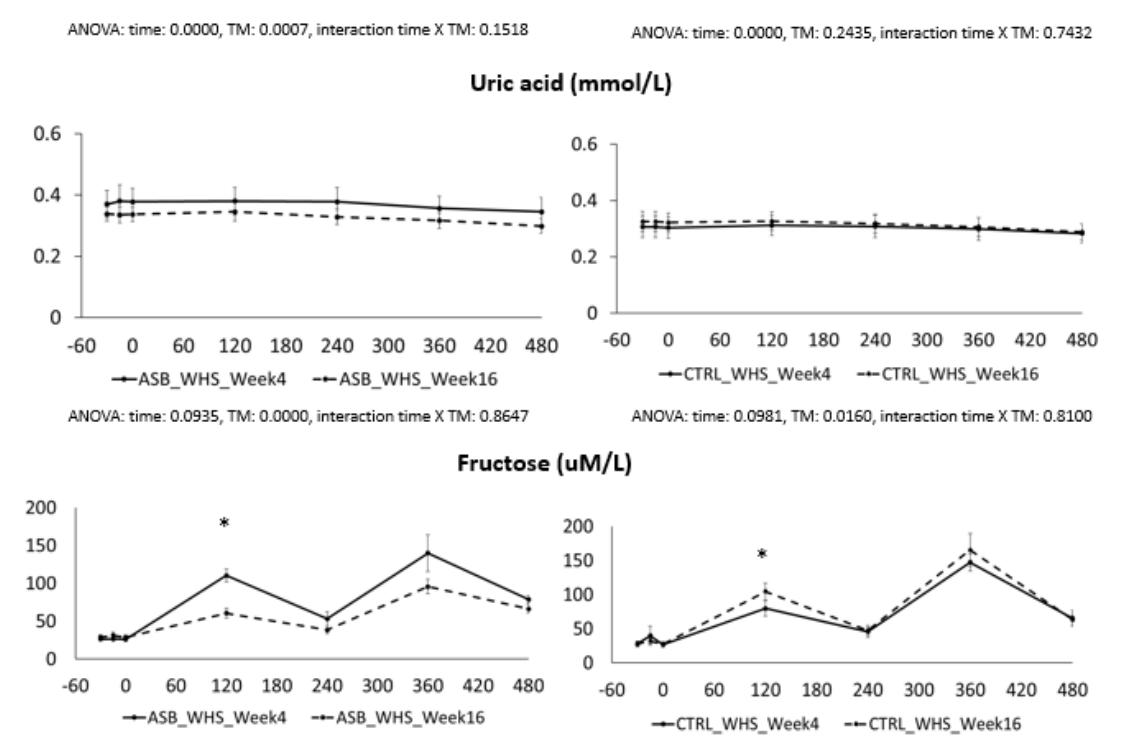
Figure 4. Plasma concentrations of TG, NEFA, uric acid, and fructose in participants without hepatic steatosis. Data are expressed as mean ± SEM.; solid lines correspond to week 4, dotted lines to week 16. Results for ASB arm are shown on the left part, and for CTRL arm on the right part of the graph. Statistics (two ‐ way ANOVA for repeated measurements with interaction) are reported at the bottom of each graph.